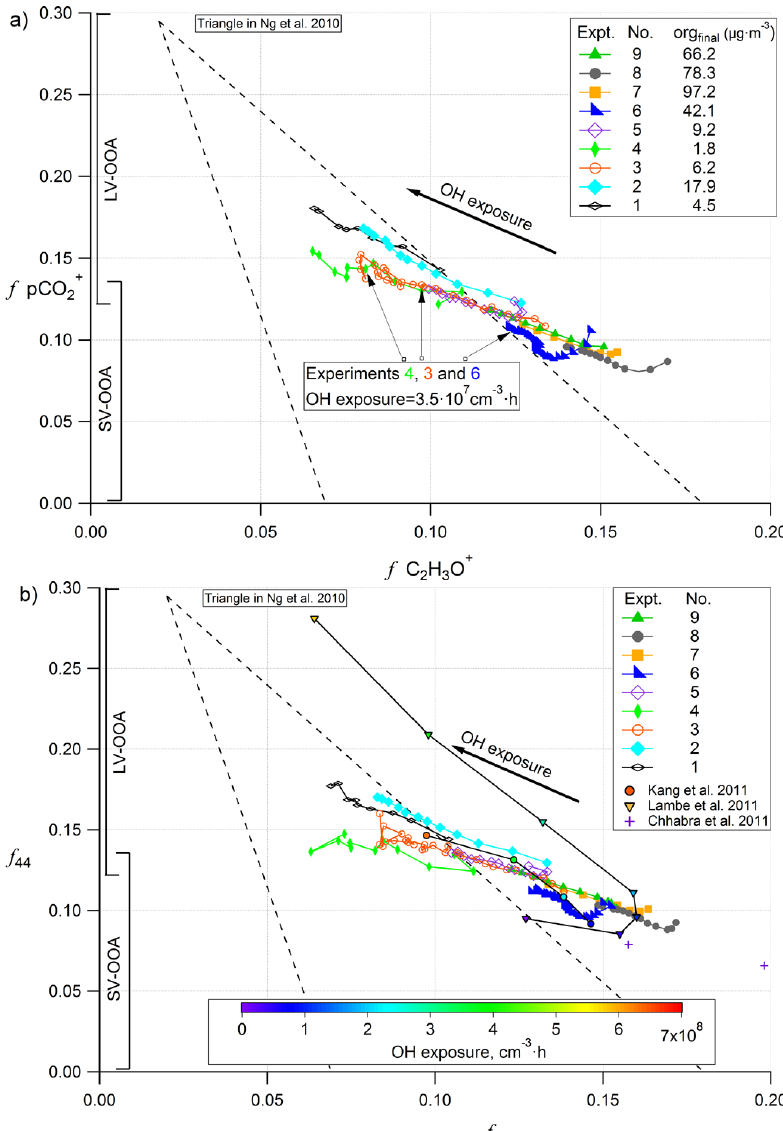
Fig. 1. (a) Thirty-minute averages (except expt. 4: 60min) of fp CO + vs. f C 2 H 3 O + color coded for the nine experiments. The legend shows 2 the final wall-loss-corrected organic mass concentration at the end of each experiment. The three arrows indicate the fp CO + - f C 2 H 3 O + pair 2 when an OH exposure of 3 . 5 × 10 7 cm − 3 h is reached for selected experiments (4, 3, 6). Dashed lines represent the observed range of ambient SOA (Ng et al., 2010). (b) Unit mass resolution organic mass fraction f 44 vs. f 43 color coded for the nine experiments. For comparison, environmental chamber (Chhabra et al., 2011) and flow reactor data (Kang et al., 2011; Lambe et al., 2011) of α -pinene photooxidation experiments are shown and color coded by the OH